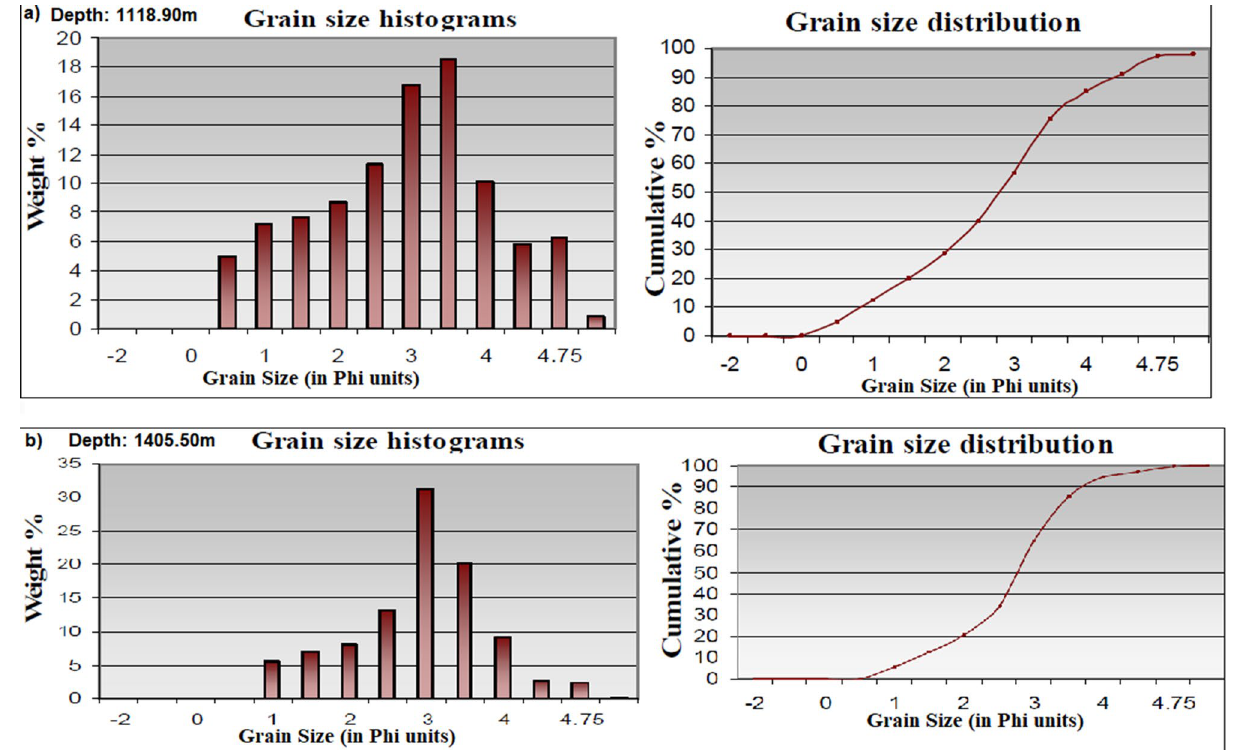
Figure 7. Grain size and sieve analyses histograms with cumulative weight percentage (curve in right) and grain size distribution (curve in left) for the studied Zarga ( a ) and Ghazal ( b ) Ripple marked sandstone and siltstone (SR). The total thickness of this facies is 5.93 m as observed in core-1 and core-2 (Table 3, Fig. 5). It is light grey to grey colour sandstone with grain-size ranging from fine upper (FU) to fine lower (FL) while the grain roundness varies from sub rounded to well round. The grains are dominantly moderately sorted. Kaolinitic matrix is present and minor amount of carbonate cement has been identified. However, despite having the same characteristics with the sandstone, the rippled laminated siltstone beds have thickness of 0.60 m, which are lesser in thickness compare to the sandstone beds. Total porosity and permeability is generally low for the analyzed samples of Sr-facies, while the other facies (St Sp and Sm) are relatively high. This facies are similar to the “Sr” facies type in Miall’s classification. It is interpreted that the ripple marked sand- stone beds were deposited on the top of fluvial bars while the rippled laminated siltstone beds were deposited on the deltaic distal bar 25 . Laminated to massive mudstone and shale (FCF/FM). This fine grained, kaolinitic rich facies is dark grey and well sorted with a total thickness of about 3.08 m present in the three studied cores samples. It is partially lami- nated and partially massive with some root casts which distinguish it from other facies such as Sr-facies. The shale component displays some degree of fissility. The facies has been described as “Fcf and Fm” according to Miall and interpreted as overbank (floodplain) deposits and deltaic distal bars 25 . Massive sandstone (SM). Massive sandstone facies type was observed in core-2 and core-3 with total thickness of 1.85 m (Table 3, Fig. 5). The facies is typically grey with grain-size between fine upper (FU) to medium lower (mL) having no evidence of lamination or ripple marks within a fining upward pattern. This well sorted grains range from rounded to sub-angular and often associated with mica and carbonate cements. An oil show with some organic matter has been observed as another feature of Sm-facies when compared to others (e.g. Fm and Sr-facies). Observed porosity is reasonable high for the sample analyzed. This massive sandstone resembles the “Sm” facies type in Miall’s classification and was formed by rapid sedimentation such as sheet-floods 25 . Trough cross‑bedded sandstone (ST). This facies is present in core-1 and core-3 with a total thickness of 1.49 m (Table 3, Fig. 5). It is grey and the grain size varies from fine upper to medium lower grained (fU—mL). The grains are sub rounded to rounded with some sub-angular grains, and are well sorted. Few amounts of mica as well as carbonate cements and some few iron oxides were noticed in form of red patches. This typical trough cross-bedded facies shows relatively high total porosity and permeability in the studied cores. Thus, it could be classified as “St” type according to Miall and interpreted as the deposits of migrating 3-D dunes in a braided channel and deltaic mouth bars 25 .